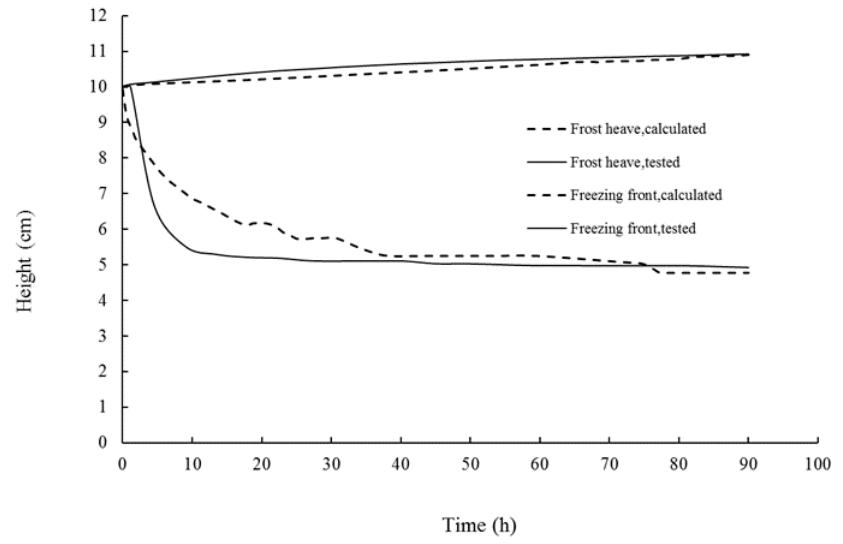
Figure 14. Comparisons of frost heaves and freezing fronts tested and calculated. Table 2. The calculated parameters. Parameter.